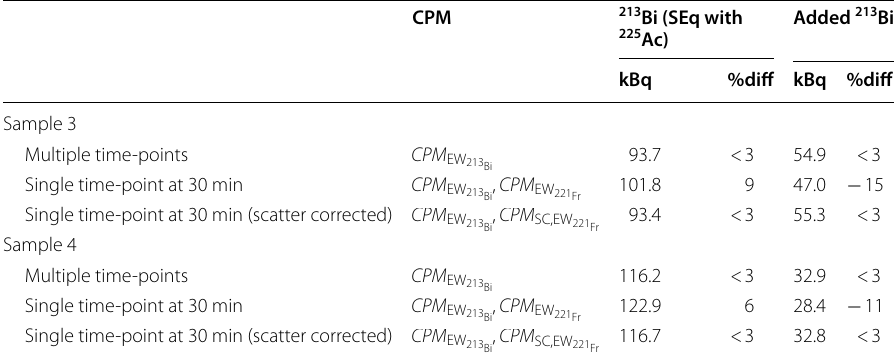
Corresponding CPM approaches are indicated and the relative difference (%diff) compared to the reference activities in both samples